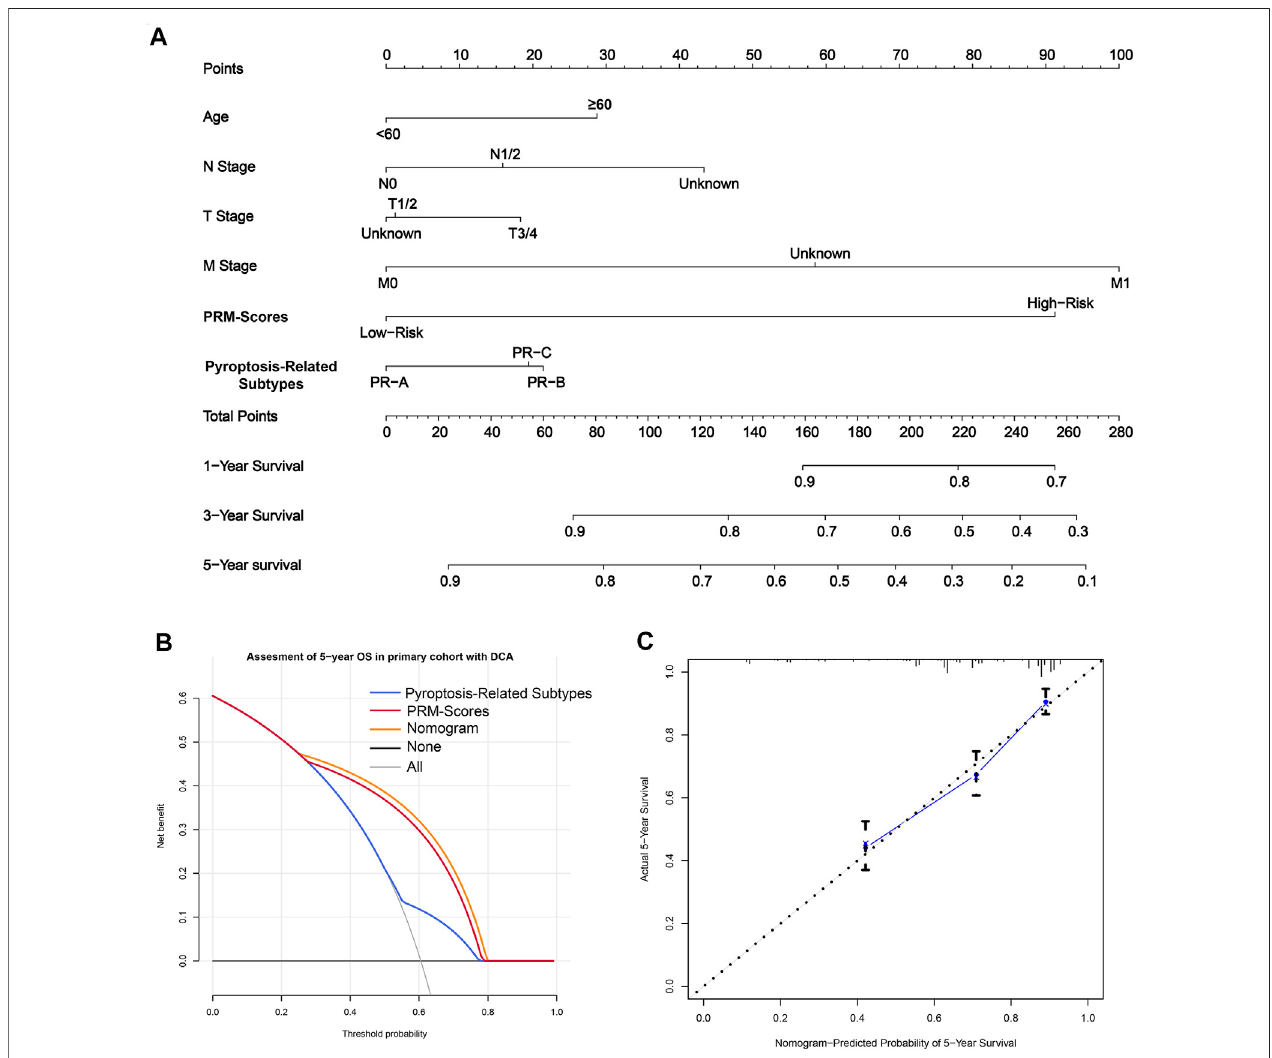
FIGURE 7 | The clinical applicationvalue ofthe PRM-scores scoring model and pyroptosis-related(PR) clusters. (A) A nomogramwas establishedfor predicting1,3, and5-yearsoverallsurvival(OS)incoloncancer.TocalculateprobabilityofOS, fi rst,determinethevalueforeachfactorbydrawingaverticallinefromthatfactortothepoints scale. “ Points ” isascoringscaleforeachfactor,and “ totalpoints ” isascalefortotalscore.Thensumupalloftheindividualvaluesanddrawaverticallinefromthetotalpoints scale to the 1, 3, and 5-years OS probability lines to obtain OS estimates. (B) The decision curve analysis (DCA) of nomogram in inner-training set for 5 years OS. (C) Calibration curves for the probability of OS at 5 years. The nomogram cohort was divided into three equal groups for validation. The gray line represents the perfect match between the actual ( y -axis) and nomogram-predicted ( x -axis) survival probabilities. Black circles represent nomogram-predicted probabilities for each group, and X ’ s represent the bootstrap-corrected estimates. Error bars represent the 95% CIs of these estimates. A closer distance between two curves suggests higher accuracy.